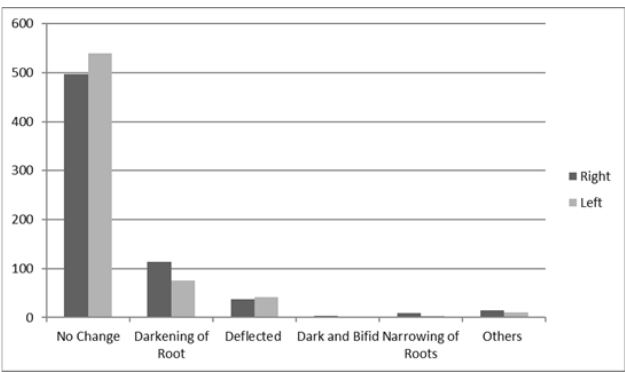
Fig. 1. Overall change in roots in our study.